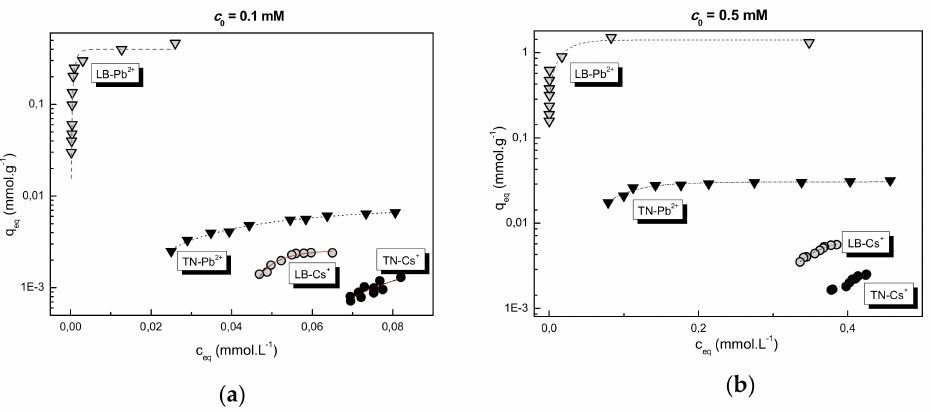
Figure 5. Langmuir adsorption isotherms of Pb 2 + / Cs + adsorption on LB and TN at di ff erent initial